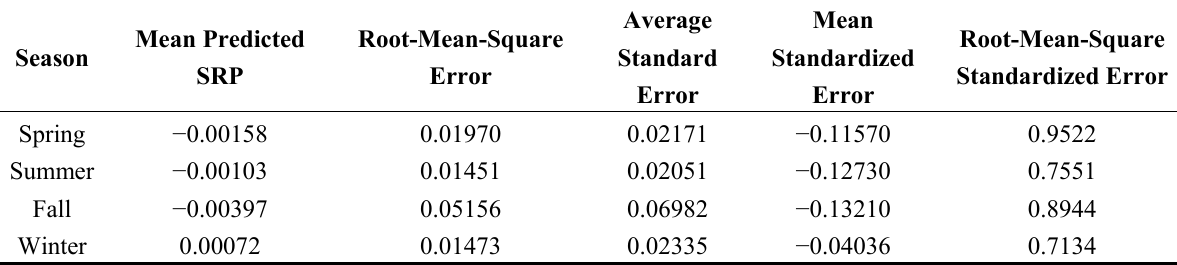
Table 2. Mean predicted SRP concentrations and error values by season for the groundwater maps in Figure